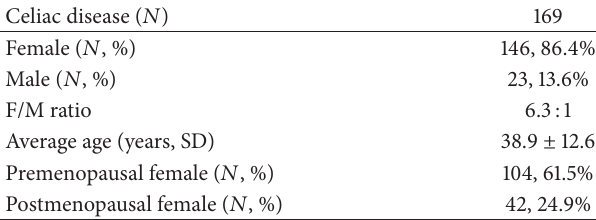
Table 1: Baseline characteristics of study population.